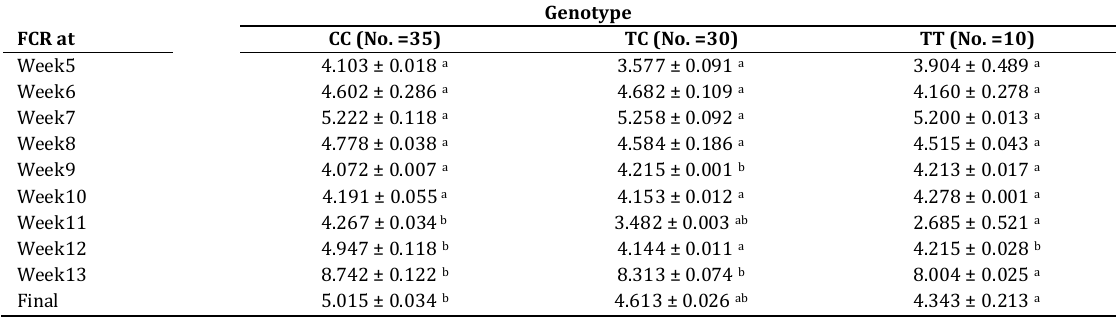
Table 6. Relationship of genotypes of the TGF- β2 gene with feed conversion ratio (FCR, g:g). Mean ± standard